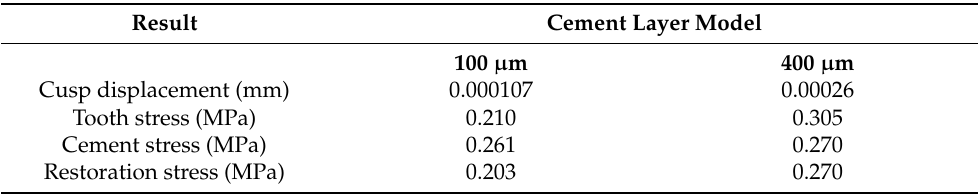
Figure 9. Maximum shear stress in the cavity margin with ( a ) 100 μm thickness cement model and ( b ) 400 μm thickness cement. It is possible to note that the shear stress was highest in the axiopulpal and buccal walls in the thicker group. Table 2. Quantitative analysis of cusp displacement, tooth stress, cement stress, and restoration stress according to the cement layer thickness.